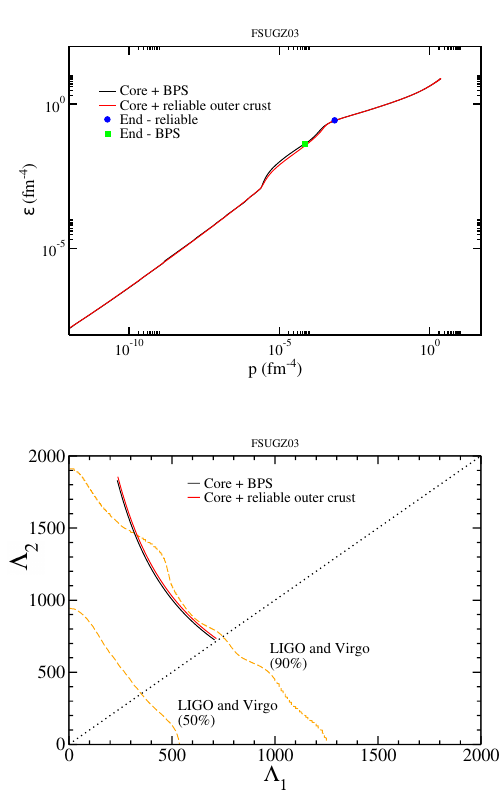
Figure 16. ( Top ) EOSs obtained with the outer crust described by BPS and by a reliable model [84]; ( Bottom ) tidal polarizabilities for both NSs with the EOSs shown on the